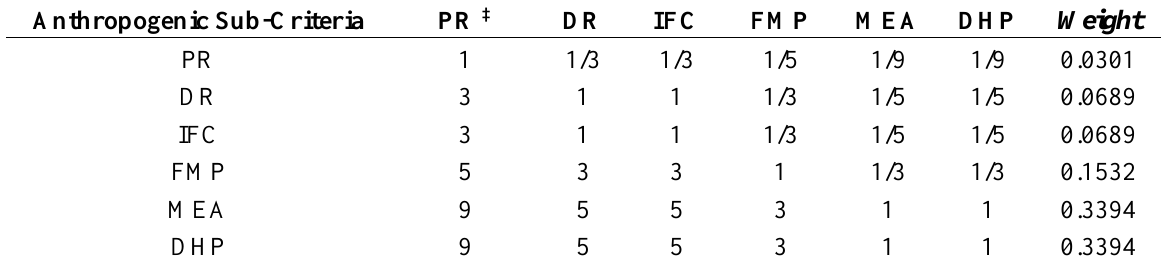
Table 3. Pairwise comparison matrix and relative weights of anthropogenic sub-criteria used to estimate the degree of risk of the populations of Pseudotsuga menziesii in central Mexico † .